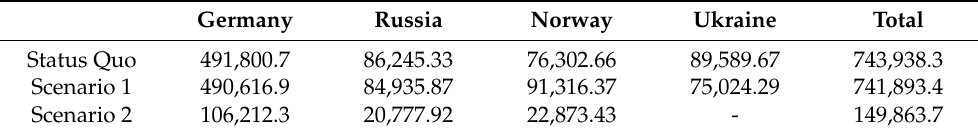
Table 4. Flexible network allocation rule results.